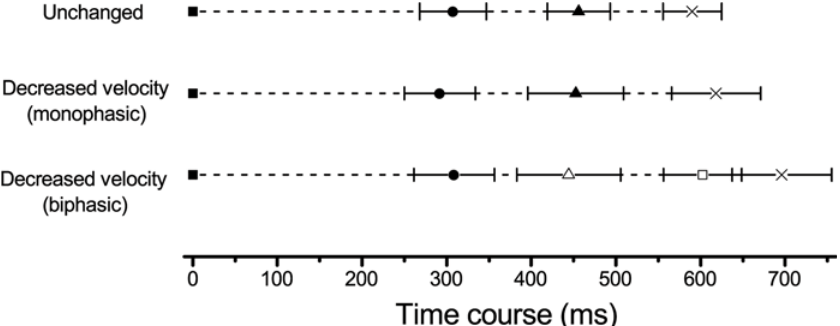
Fig 2. Outline of elapsed time from moment that target started to move until impact in response to unchanged and decreased velocity. Data are shown as means and SD. Target start ( & ), Onset of EMG activation ( ● ), time to peak EMG amplitude in response to unchanged condition and monophasic EMG pattern in decreased velocity condition ( ▲ ), time to peak EMG amplitude of first ( 4 ) and second ( □ ) peaks in response to biphasic EMG pattern in decreased velocity condition, impact time